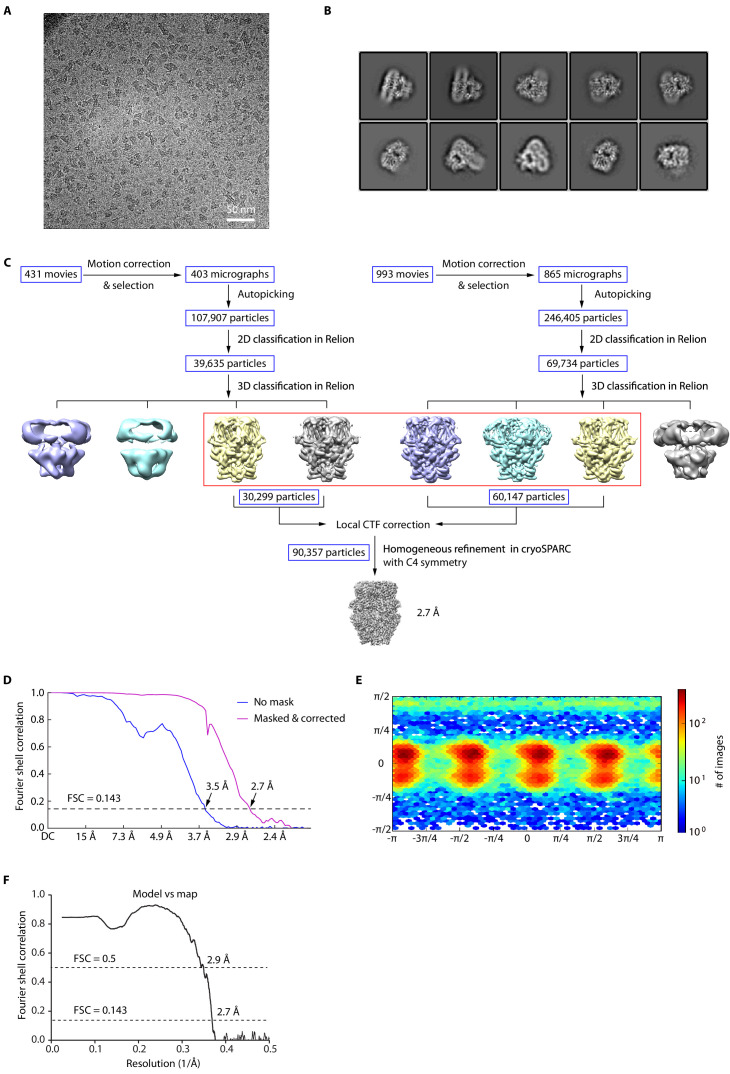
Cryo-EM image analysis of clemizole (CMZ)-bound human TRPC5 (hTRPC5).(A) Representative raw micrograph recorded on K2 Summit camera. (B) Representative 2D class averages of CMZ-bound hTRPC5. (C) Flowchart for cryo-EM data processing of CMZ-bound hTRPC5. (D) Fourier shell correlation (FSC) curves of the two independently refined maps for unmasked (blue line, 3.5 Å) and corrected (purple line, 2.7 Å). Resolution estimation was based on the criterion of FSC 0.143 cut-off. (E) Angular distribution of CMZ-bound hTRPC5. This is a standard output from cryoSPARC. (F) FSC curve of the refined model versus EM map.